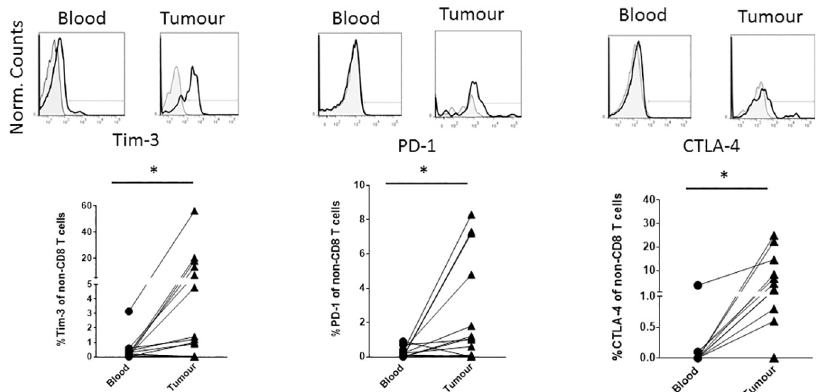
Fig 4. The proportion of non-CD8 T cells expressing Tim-3 and CTLA-4, but not PD-1, is elevated in tumour relative to the blood. Upper plots are an exampleof antibody stainingfor each indicatedreceptor after gatingon live, CD45 + , CD3 + , CD8 + cells. Shadedplots represent negative control staining. The lower graphssummarise the percentage of PD-1, Tim-3 and CTLA-4 + cells (after subtractionof negative control percentage staining)for individual patients. The lines connect the matched blood and tumour sample from each individualpatient. * indicatesp < 0.05.